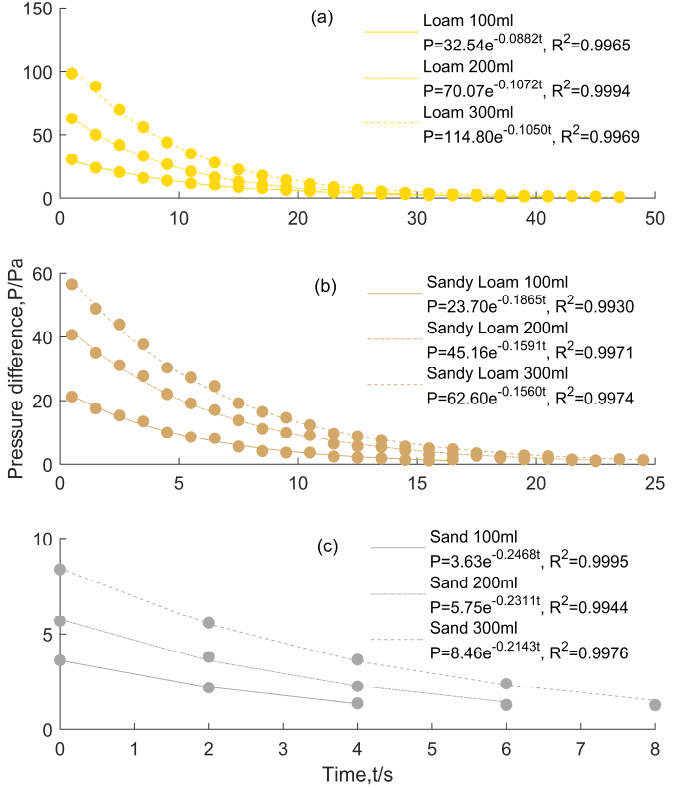
Figure 5. Pressure decay curves for three different soil porous media: ( a ) Loam, ( b ) Sandy loam, and ( c )